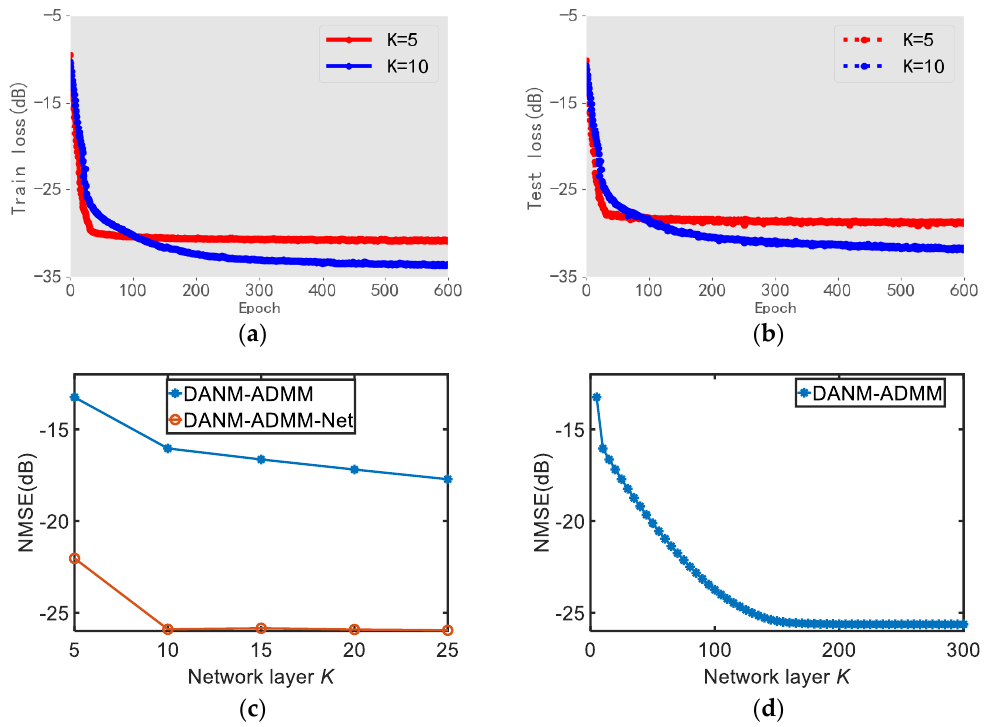
Figure 5. Convergence performance of DANM-ADMM-Net and its comparison with DANM-ADMM algorithm. ( a ) Train NMSEs when K = 5/10. ( b ) Test NMSEs when K = 5/10. ( c ) Test NMSEs when K = 5 ∼ 25. ( d ) Test NMSEs when K = 5 ∼